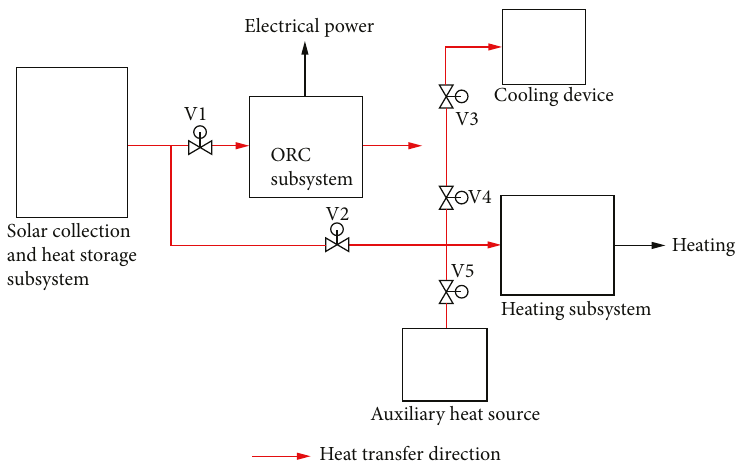
Figure 10: Form of the cogeneration system. Table 4: The speci fi c state of the solenoid valves in di ff erent operating modes when the solar collectors are PTC. Operating modes